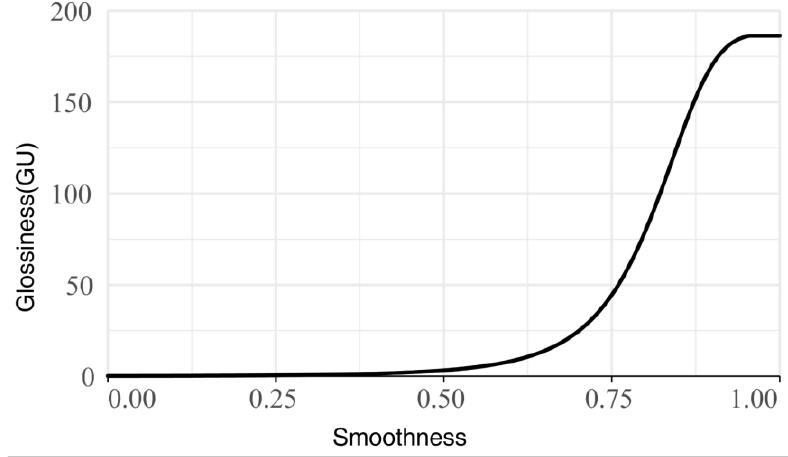
Figure 9. The mapping curve between PBR smoothness and physical glossiness (GU).